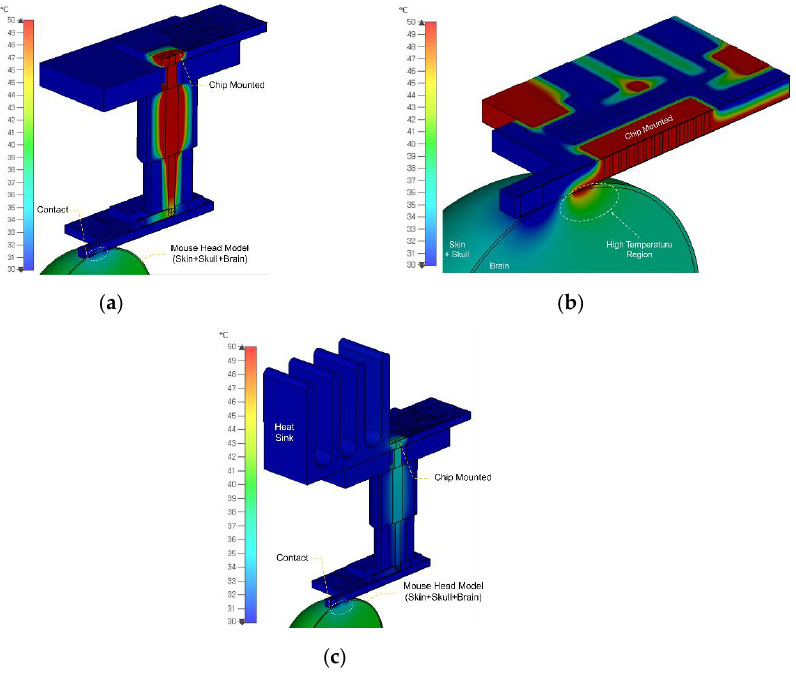
Figure 8. Simulated ( a ) direct chip-on-probe, ( b ) chip-on-probe using an auxiliary PCB with a RF connector, and ( c ) heat sink added for 2 W chip heat dissipation.